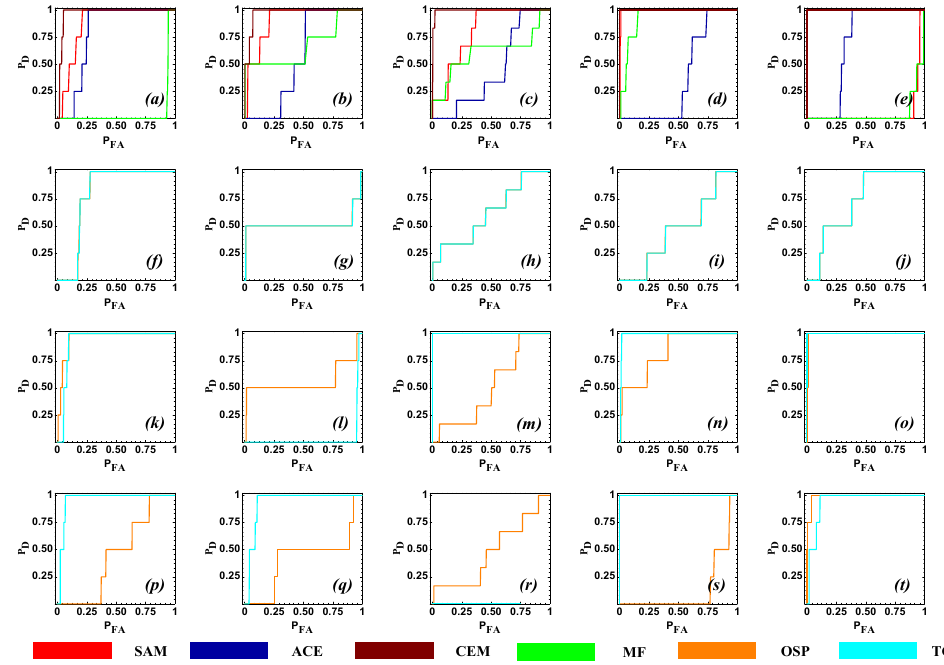
Figure 7. Target detection performance comparison from space-borne imagery for the in-situ target reference spectra. ROC curves for the detection from SAM, ACE, CEM, and MF for the ( a ) N1G, ( b ) N2R, ( c ) N3Y, ( d ) C1W, and ( e ) N4B targets. ROC curves for the subspace-based detector OSP and TCIMF for the N1G, N2R, N3Y, C1W, and N4B targets for ( f – j ) 5, ( k – o ) 10, and ( p – t ) 15 endmember/background materials.